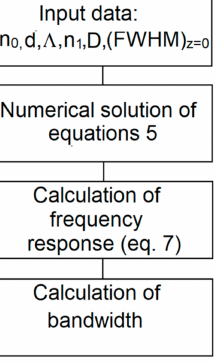
Figure 4. Block diagram for the calculation of the bandwidth in SI